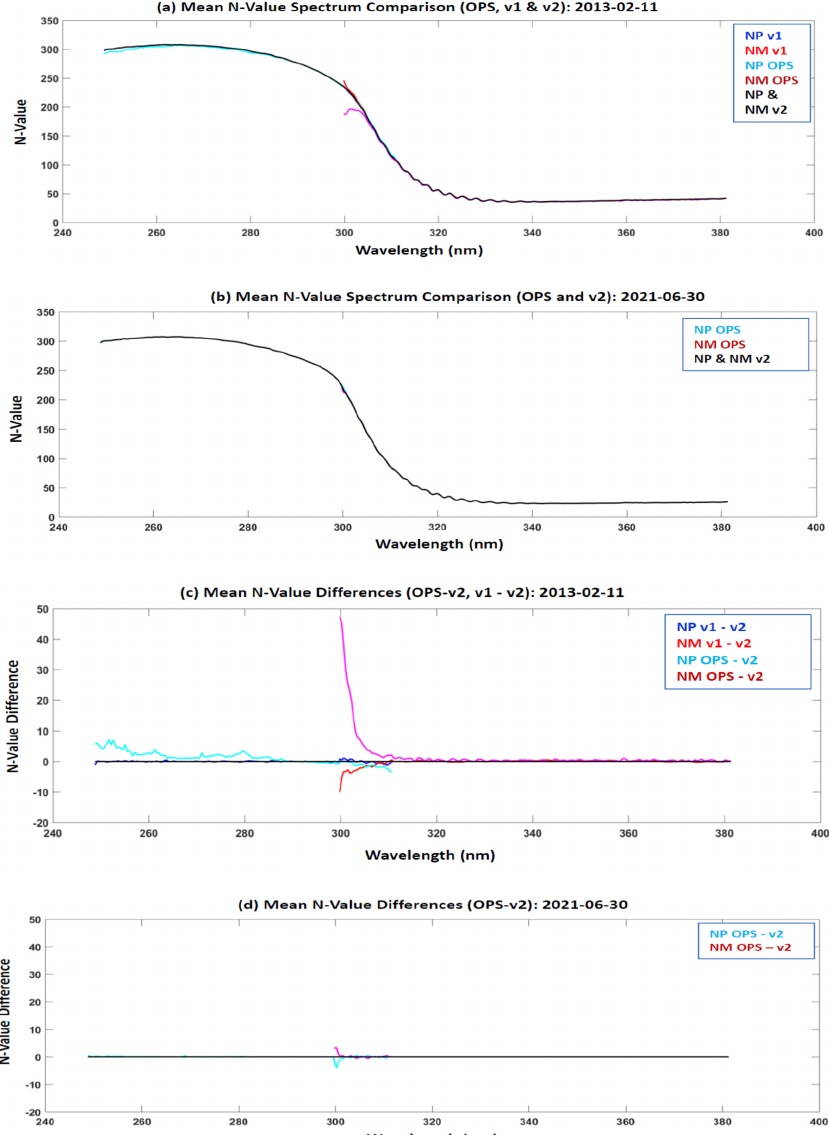
Figure 15. Same as Figure 14 except for N-value. ( a ) Averaged N-value spectra using the three data sets (OPS, v 1 , and v 2 ) in combination of OMPS NM and NP together on 11 February 2013. ( b ) Same as ( a ) except for 30 June 2021. ( c ) Averaged N-value differences of the OPS or v 1 data sets from the v 2 data set on 11 February 2013. ( d ) Same as ( c ) except for 30 June